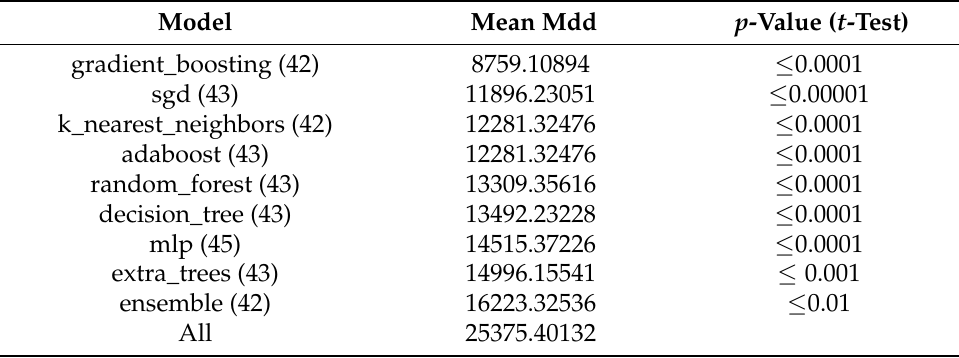
Table A16. Models with significantly better mean maximum